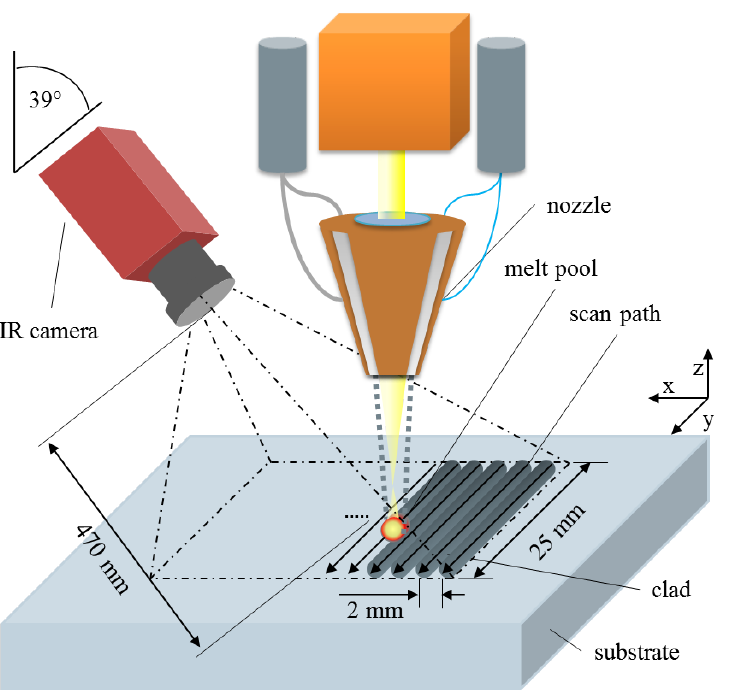
Figure 1. Schematic of the experimental